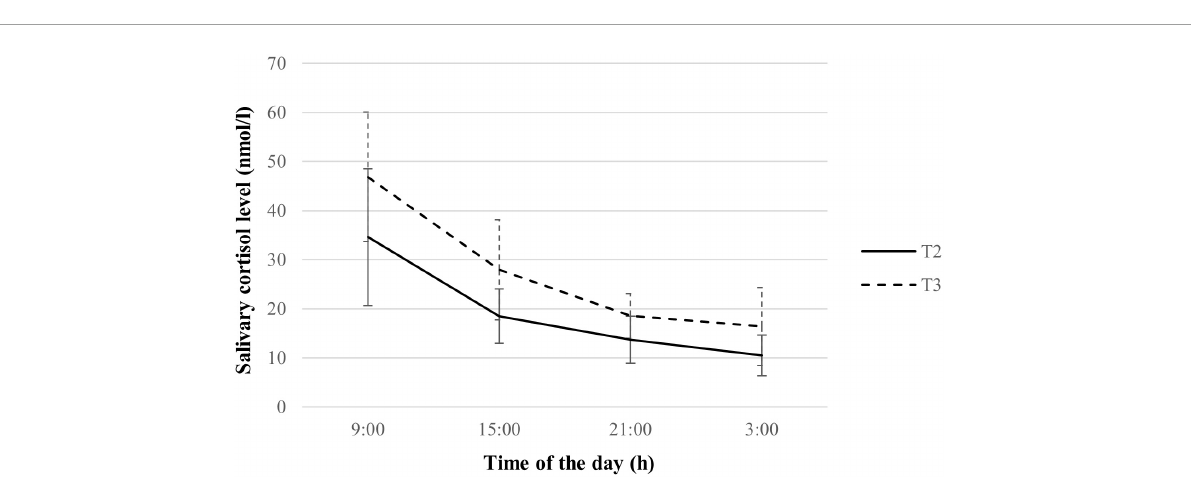
FIGURE2 Salivary cortisol rhythm of study subsample during the second and third trimesters ( n = 70). Values are expressed in median ± median absolute deviation. T2, second trimester; T3, third